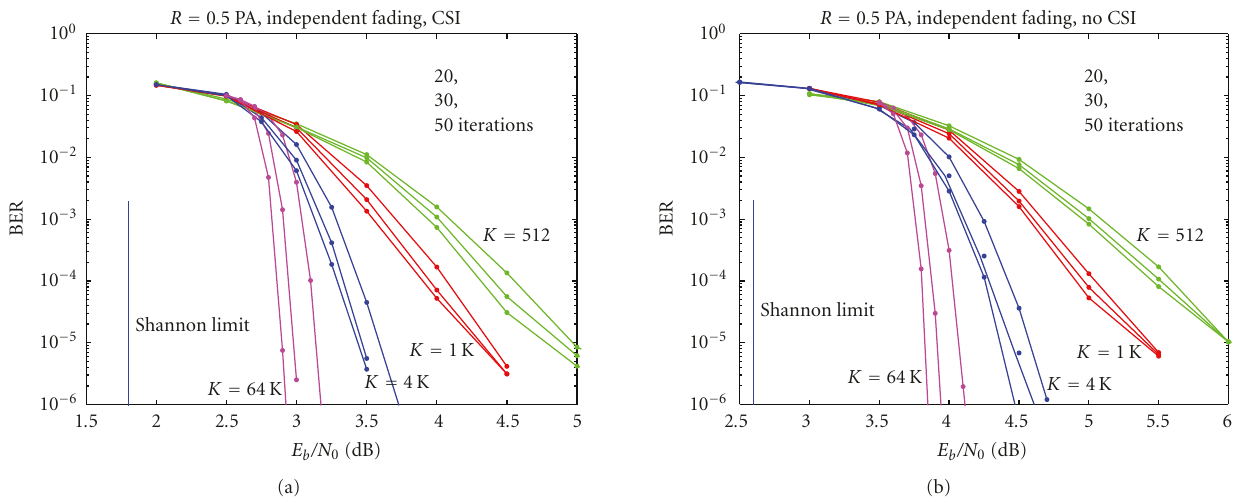
Figure 4: Performance of PA codes on independent Rayleigh fading channels. Code rate 0.5, data block size 512, 1 K, 4K, 64K. (a) With CSI; (b) without CSI.